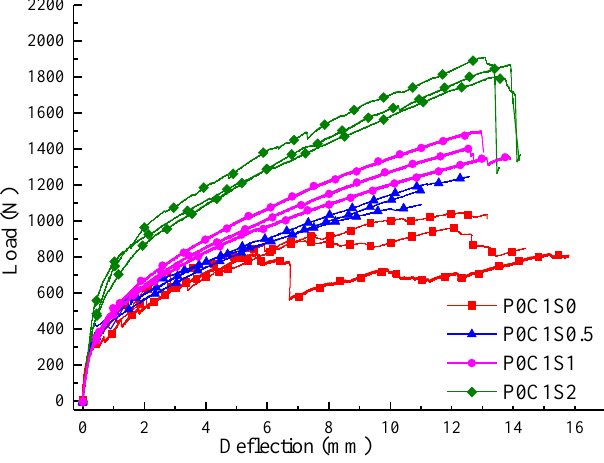
Figure 14. Load-deflection curves of the TRC specimens with different volume contents of steel fibres.